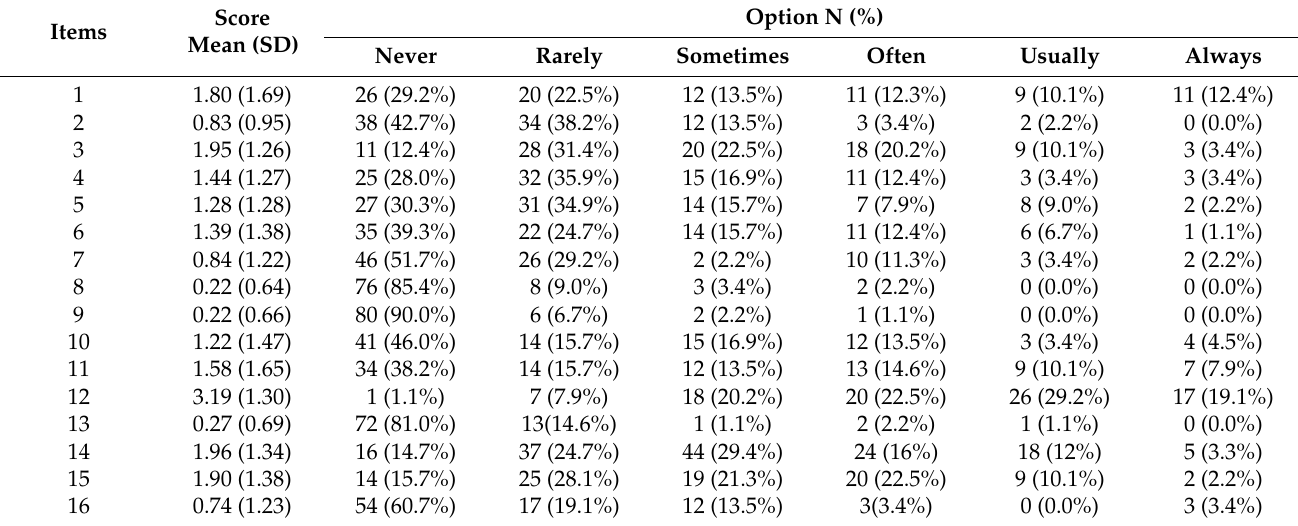
Table 3. Distribution of item scores on the C-DEPS-R among youths ( n =